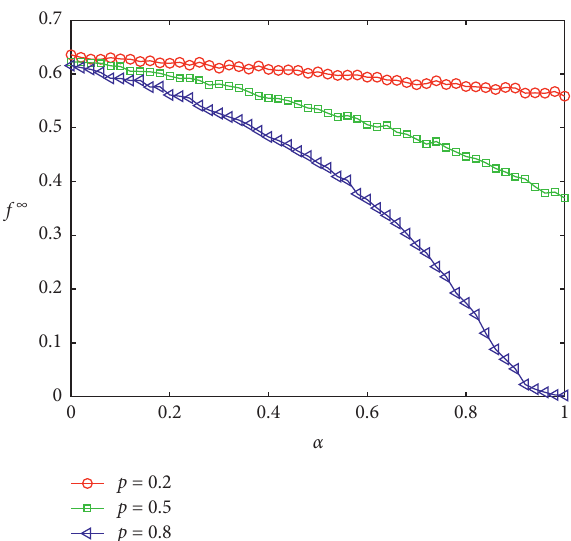
Figure 2: The infected density f t changes with time t . With the Figure 4: The final infected density f ∞ changes with the regional , the value of f t gradually increases. increase of the infection rate λ heterogeneous infection coefficient. With the increase of α , the final 0 Parameters are set to be p � 0 . 5, β � 0 . 2, α � 0 . 1. density of infected f ∞ in the whole system decreases gradually. Parameters are set to be β � 0 . 1, λ � 0 .